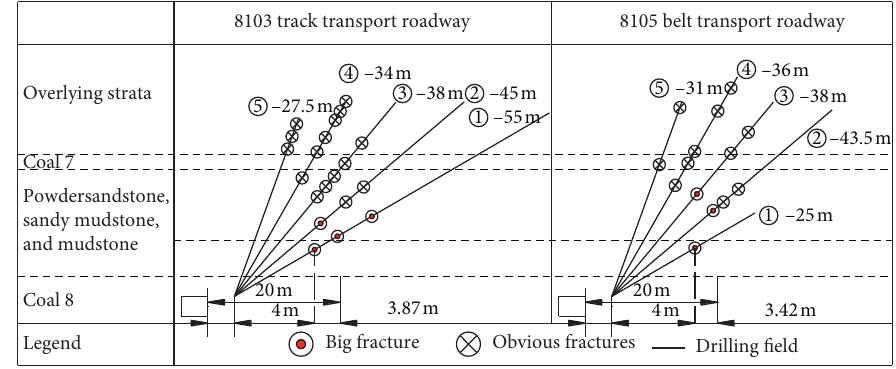
Figure 5: Probing results of the main roof fracture location.